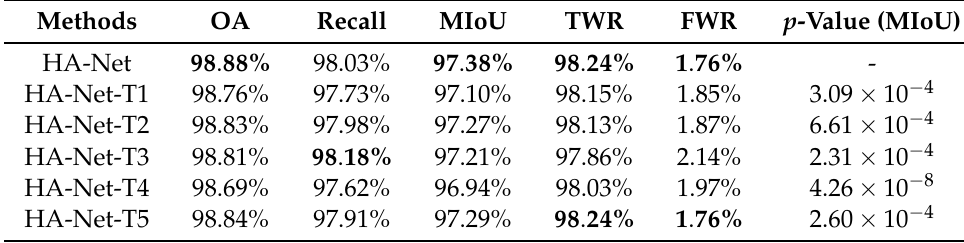
Table 6. Ablation experiments of attention blocks and different upsampling